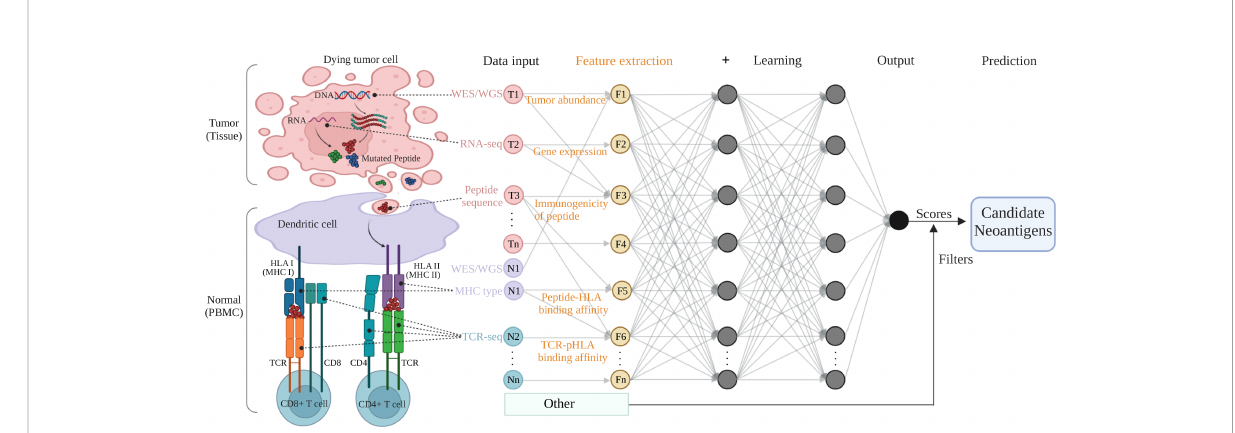
FIGURE 1 A typical multi-layer neural network architecture showing the feature extraction and prediction procedures for neoantigen predicting. Tumor (tissue) and normal (PBMC) samples are processed by NGS-based genomic pro fi ling (WES/WGS etc.) and undergo bioinformatic analysis to produce input data for machine learning training. The key features (tumor abundance etc.) extracted from the input data are fed to a typical neural network (deep learning) model and fi lters to output a predicting score (or a predicted value) for the class (positive or negative for neoantigen) the input data belongs to. The colored circles represent the input data collected from tumor components (pink, T1 to Tn) and normal cells or immune receptors (purple or sapphire, N1 to Nn), as well as the feature variables (yellow, F1 to Fn) extracted from the omics data input. The gray arrows that connect the circles shows how all the neurons are interconnected and stacked together to constitute a layer, and the multiple layers piled next to each other to construct the neural network model. Figure was created with